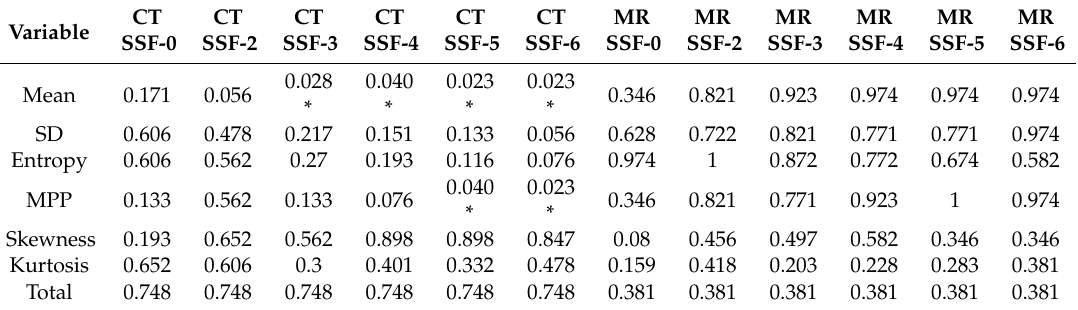
Table 3. Analysis of p-values for CT and MR texture features across two groups. * indicates a statistically significant di ff erence in texture analysis feature extraction value between groups using the Mann–Whitney